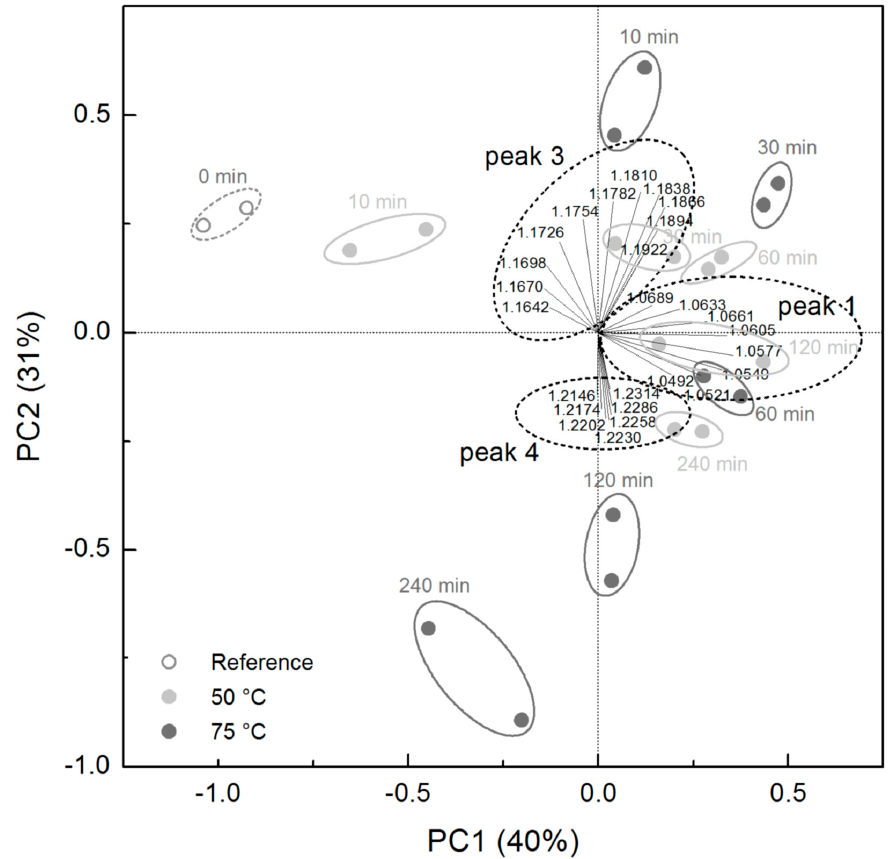
Figure 2. Principal component analysis of IM spectra of dark chocolate mass after different times of conching at 50 °C or 75 °C. Reference is chocolate mass before conching. Dotted line ellipses indicate groups of relative drift times identified at the respective peaks.